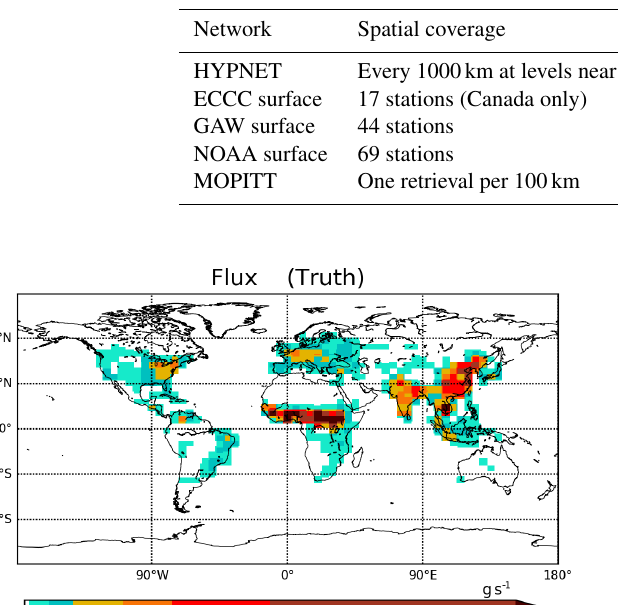
Table 2. CO observation networks used in this work.